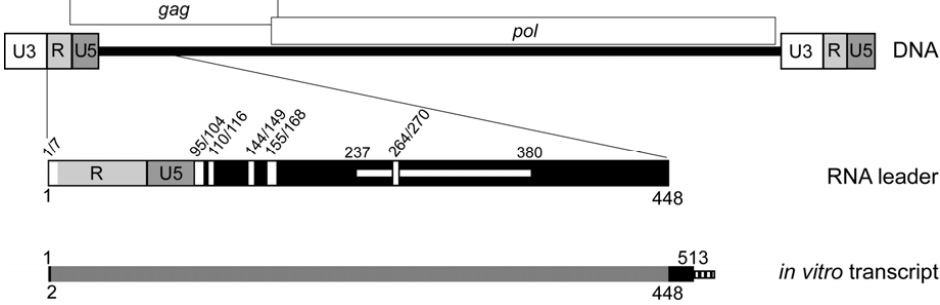
Figure 1. Schematic of the Ty1 element DNA, the Ty1 RNA 5 ′ TIPIRT domain and in vitro transcripts analyzed by SHAPE chemistry. Ty1 retrotransposon DNA consists of two 334 bp long terminal repeats (LTRs; represented by tripartite rectangles) composed of U3 (unique to the 3 ′ end of the RNA), R (repeated at the 5’ and 3 ′ ends of the RNA) and U5 (unique to the 5’ end of Ty1 RNA). LTRs flank a central coding region (black bar). The GAG and POL ORFs are denoted by rectangles above the element. Below the DNA, the 5 ′ leader of Ty1 RNA from nucleotide 1 (the beginning of “R”) to nucleotide 448 (in the GAG ORF), which includes the TIPIRT domain (nucleotides 1–380), is represented below the Ty1 element DNA. Vertical white rectangles denote sequences that are essential for initiation of reverse transcription (1/7 and 264/270 pseudoknot S1 stem; 95/104 ‐ PBS; 110/116 ‐ Box 0; 144/149 ‐ Box 1; 155/168 ‐ CYC5, including Box 2.1). The horizontal white rectangle spanning nucleotide 237–380 denotes a region required for Ty1 RNA packaging. The schematic at the bottom represents the in vitro transcript (nucleotides 1–513, plus an FTL tag indicated by the striped box) that was analyzed by SHAPE. Grey shading (nucleotide 2–448), region for which SHAPE reactivities were